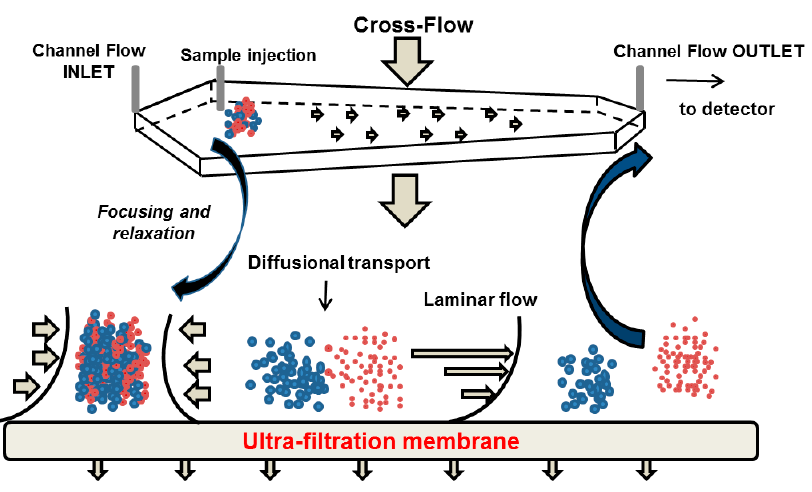
Figure 12. Schematic illustration of the separation mechanism using asymmetrical flow field flow fractionation.